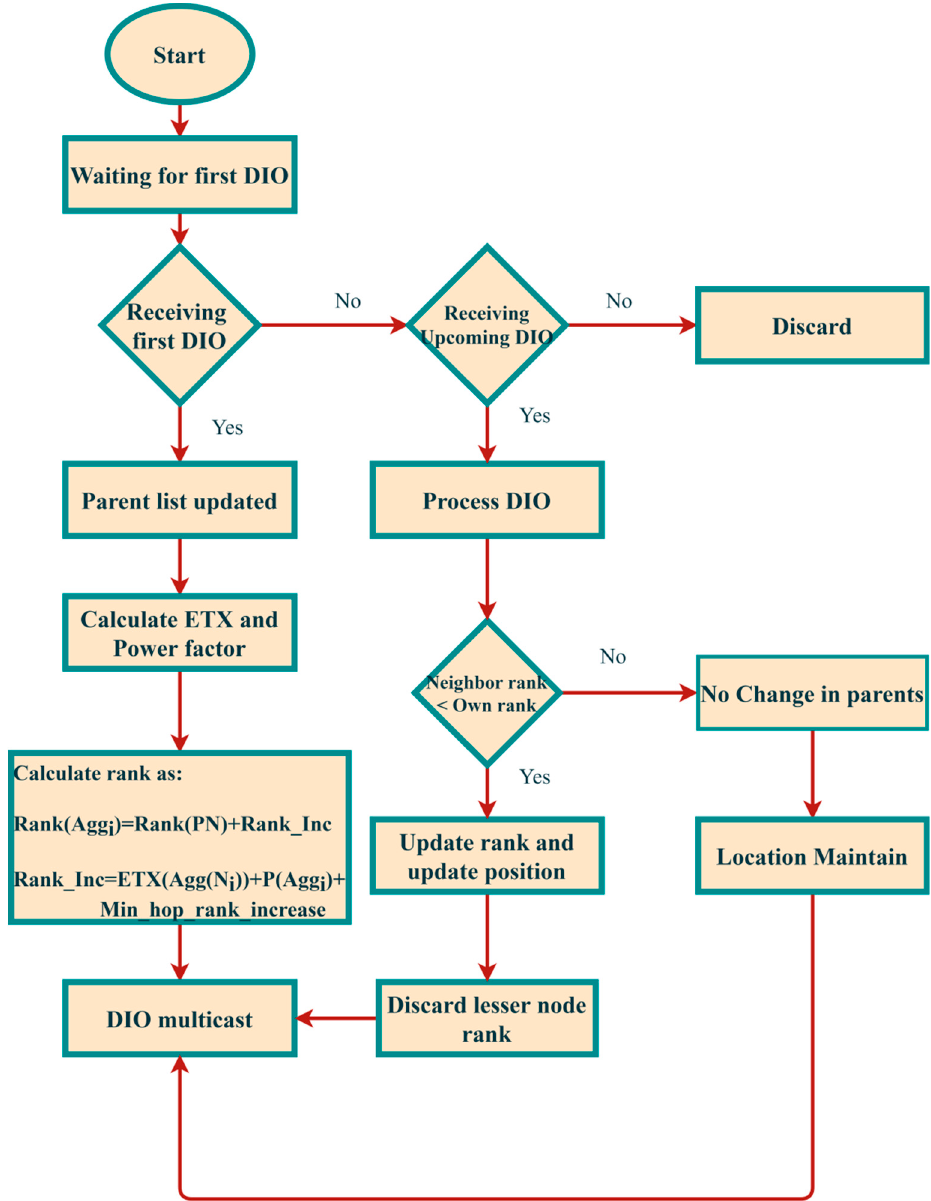
Figure 3. Parent selection based on ETX and energy.